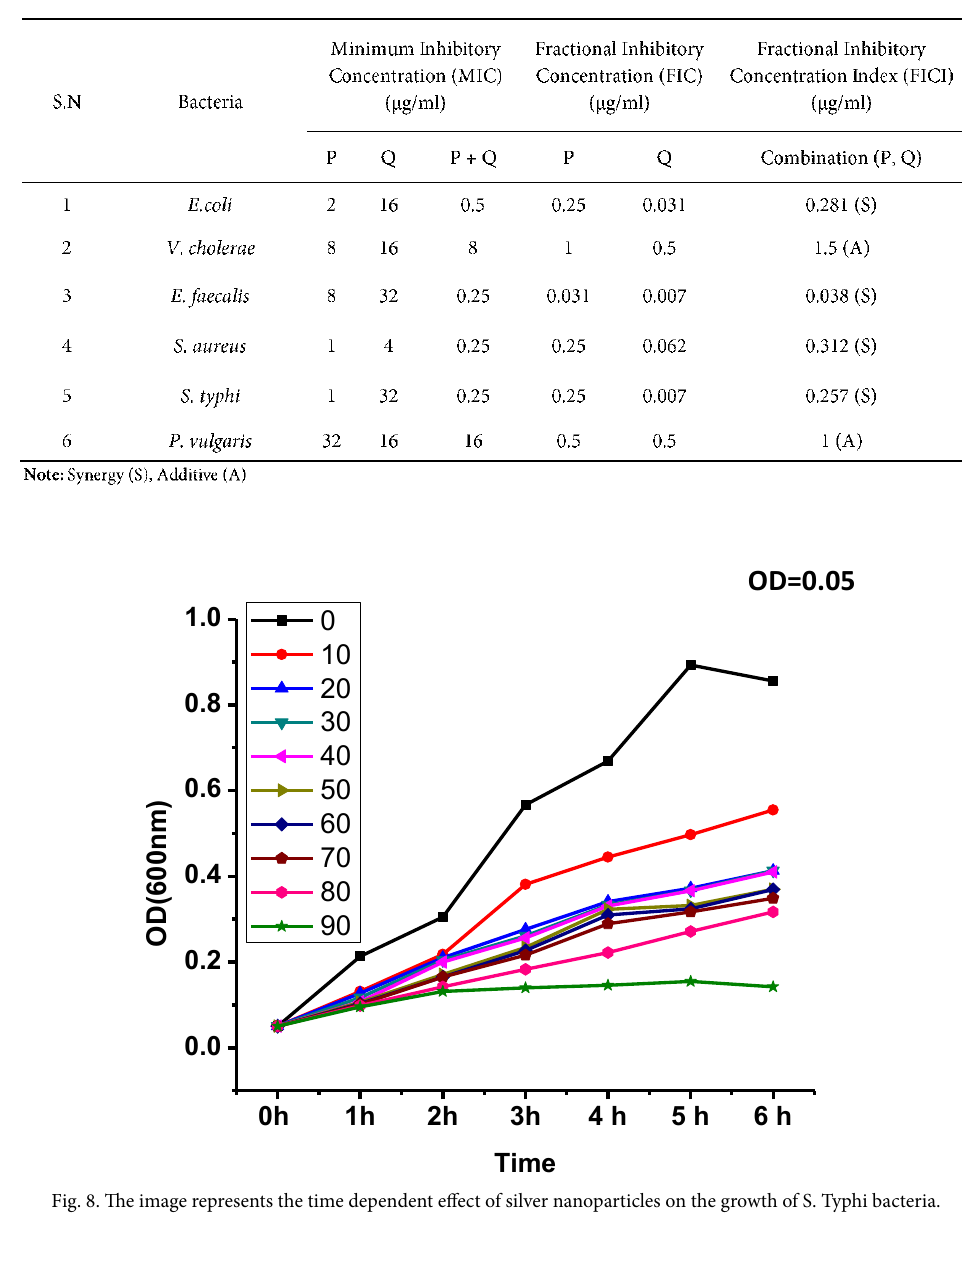
Table 3. The table represents the Minimum Inhibitory Concentration, Fractional Inhibitory Concentration and Fractional Inhibitory Concentration Index of Levofloxacin (P), AgNPs (Q), and its combination (P+Q)